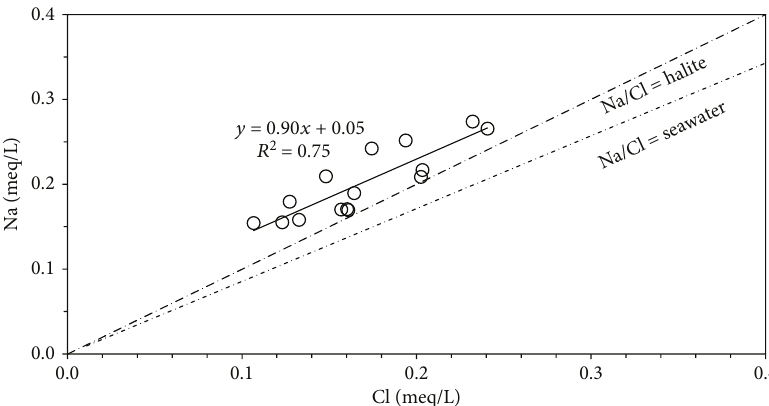
Figure 7: Na + vs. Cl - in meq/L. The reference lines of the Na/Cl ratio in halite and seawater are also displayed.